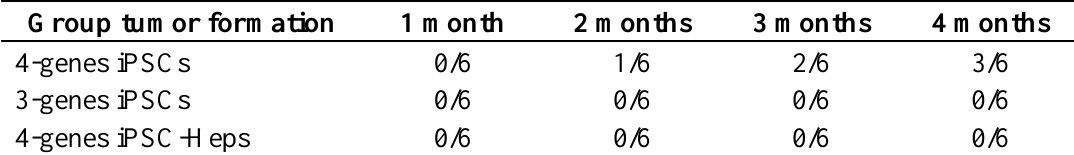
Table 2. Incidence of tumor formation in recipients of 4-genes iPSCs, 3-genes iPSCs, or 3-genes iPSC-Heps four months after